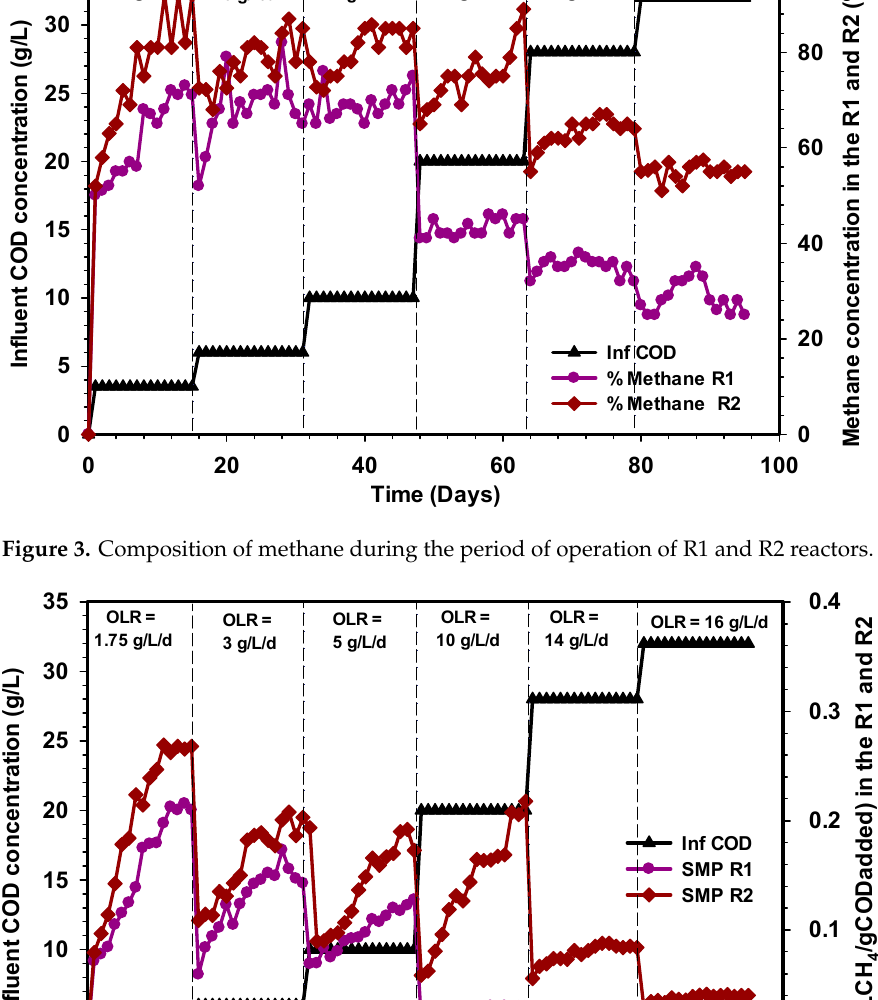
Figure 4. Variation of specific methane production (SMP) in the R1 and R2 reactors .